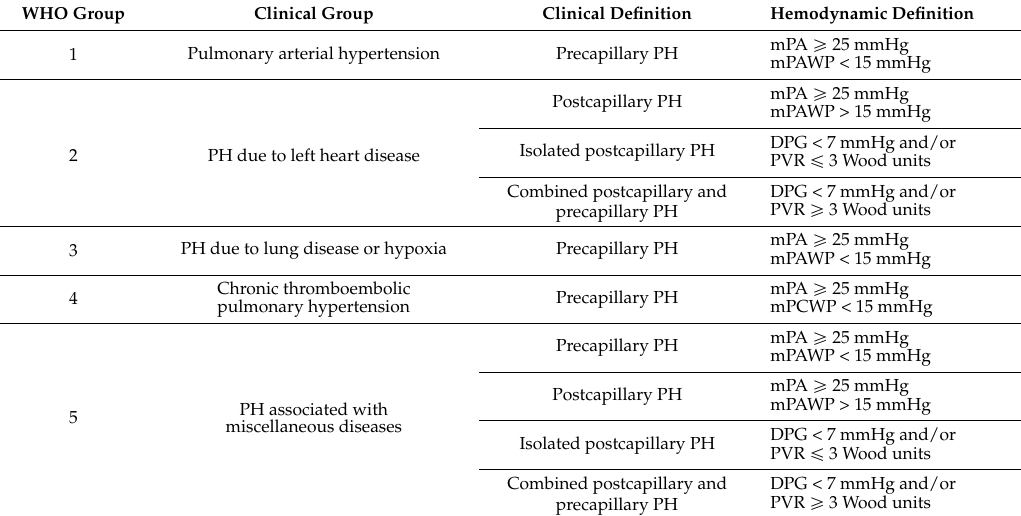
Table 1. Classification of pulmonary